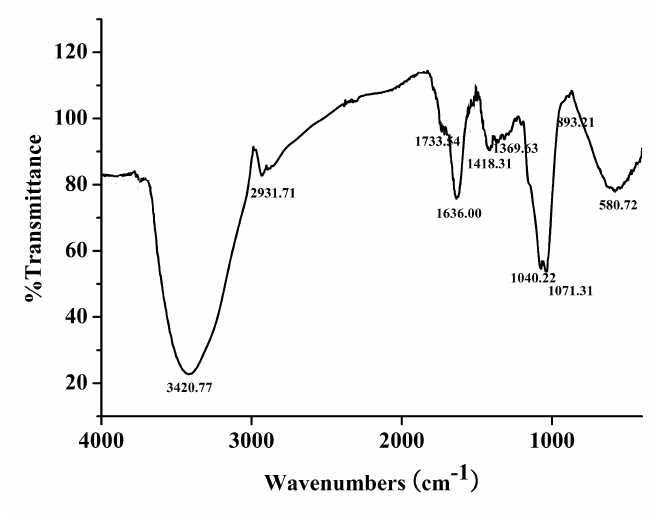
Figure 3. FTIR spectrum of degraded PRG (DPRG).